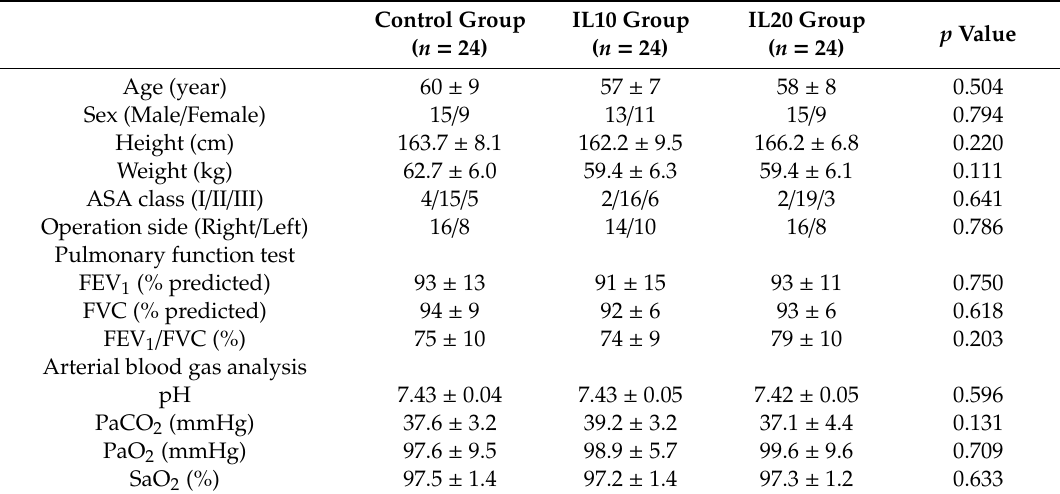
Table 1. Preoperative characteristics.